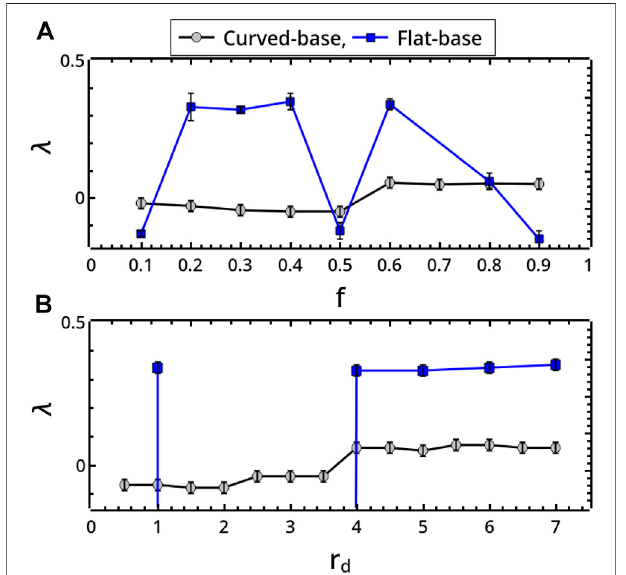
FIGURE 5 | Exponential divergence, λ , characterizing milling body trajectories in the fl at- and curved-base geometries when changing (A) the restitution coef fi cient f ( r d = 5 mm) and (B) the milling disc radius r d ( f = 0.5). λ was obtained through the formula (cid:3) δ ( t ) (cid:3) ≃ (cid:3) δ 0 (cid:3) e λ t , by calculating the distance (cid:3) δ ( t ) (cid:3) at any time t between two trajectories starting from in fi nitesimally distant conditions (cid:3) δ 0 (cid:3) → 0 (here (cid:3) δ 0 (cid:3) ~ 10 – 7 mm) for t ≫ 1 (here after 50 s) (Kantz and Schreiber, 1997).